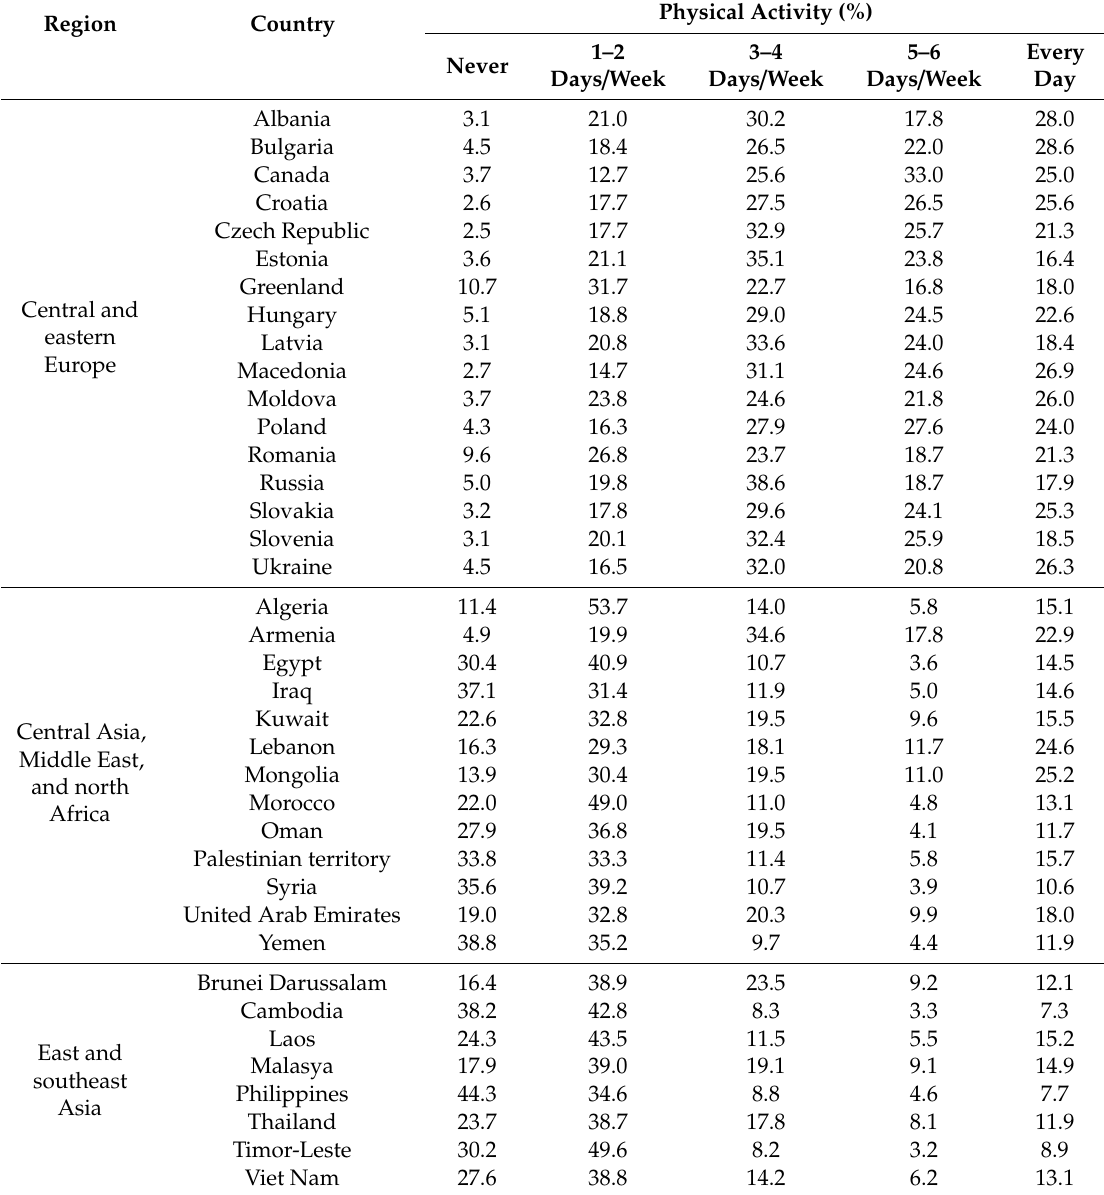
Table A1. Physical activity levels by region and